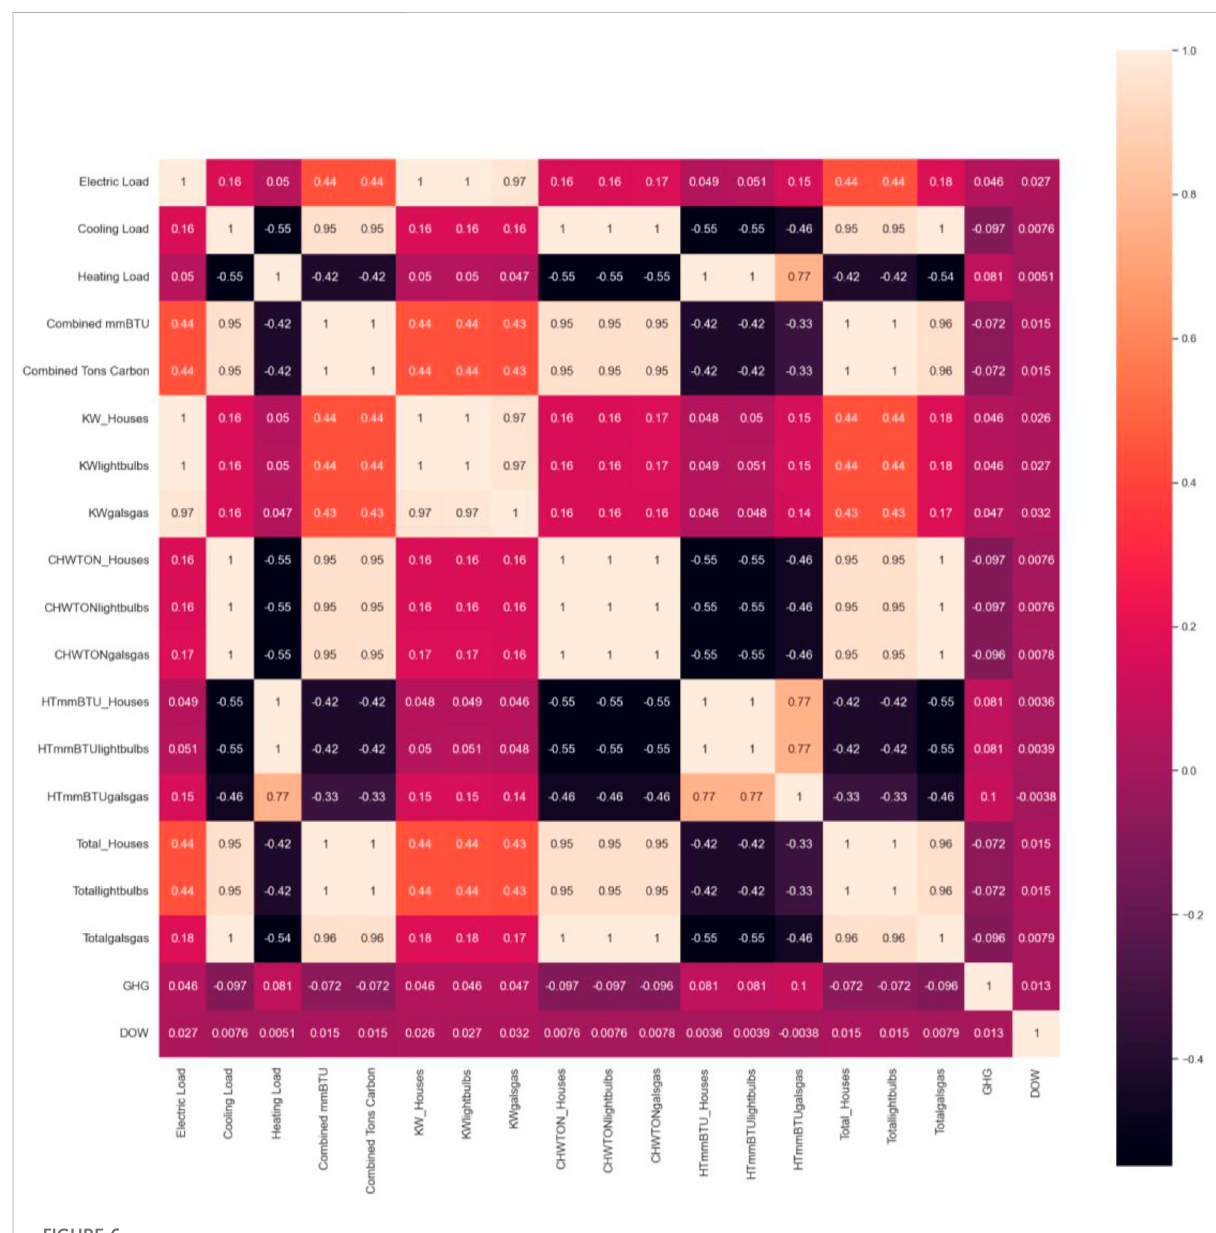
FIGURE 6 Correlation between cooling, heating and the electrical load